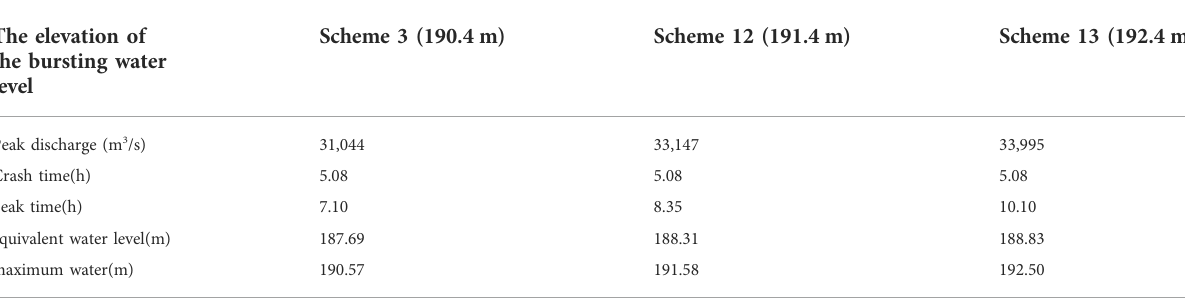
TABLE 4 Information on the peak discharge of the dam